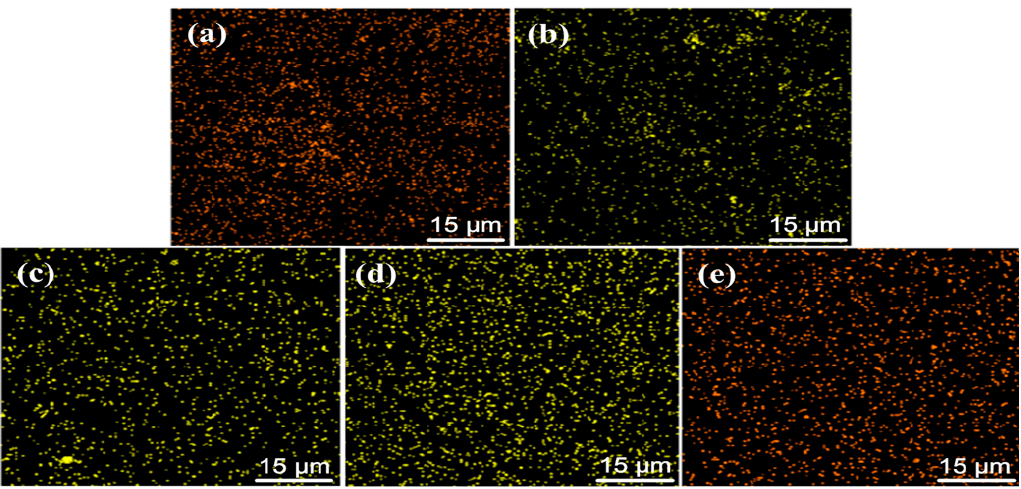
Figure 4. X-ray maps of Si analysis in the extruded 0.5 vol % n-SiC p / AT81 composites reinforced by: ( a ) untreated; ( b ) 973 K/2 h; ( c ) 1073 K/2 h; ( d ) 1173 K/2 h; and ( e ) 1273 K/2 h treated n-SiC p .